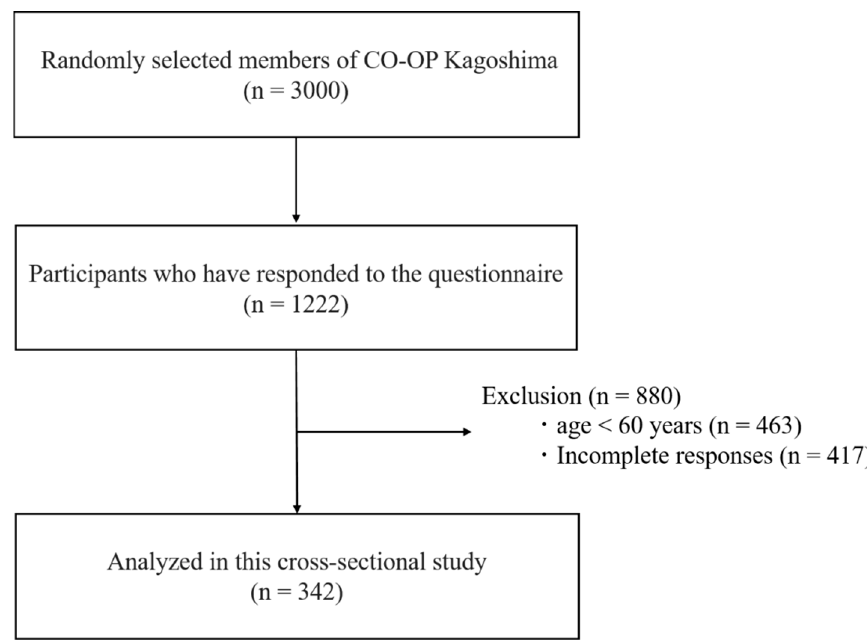
Figure 1. Flowchart for determining the participants.